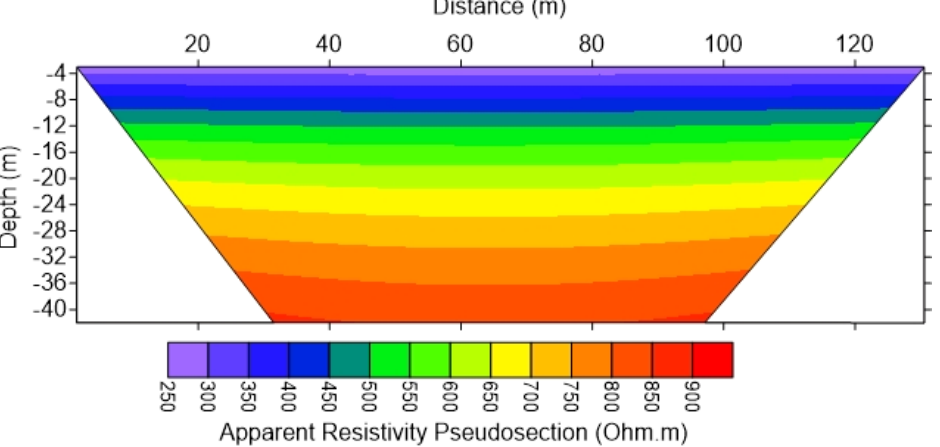
Figure 12. The resistivity cross section corresponding to the model structure in Table 2 is shown in terms of the apparent (observed) resistivity values